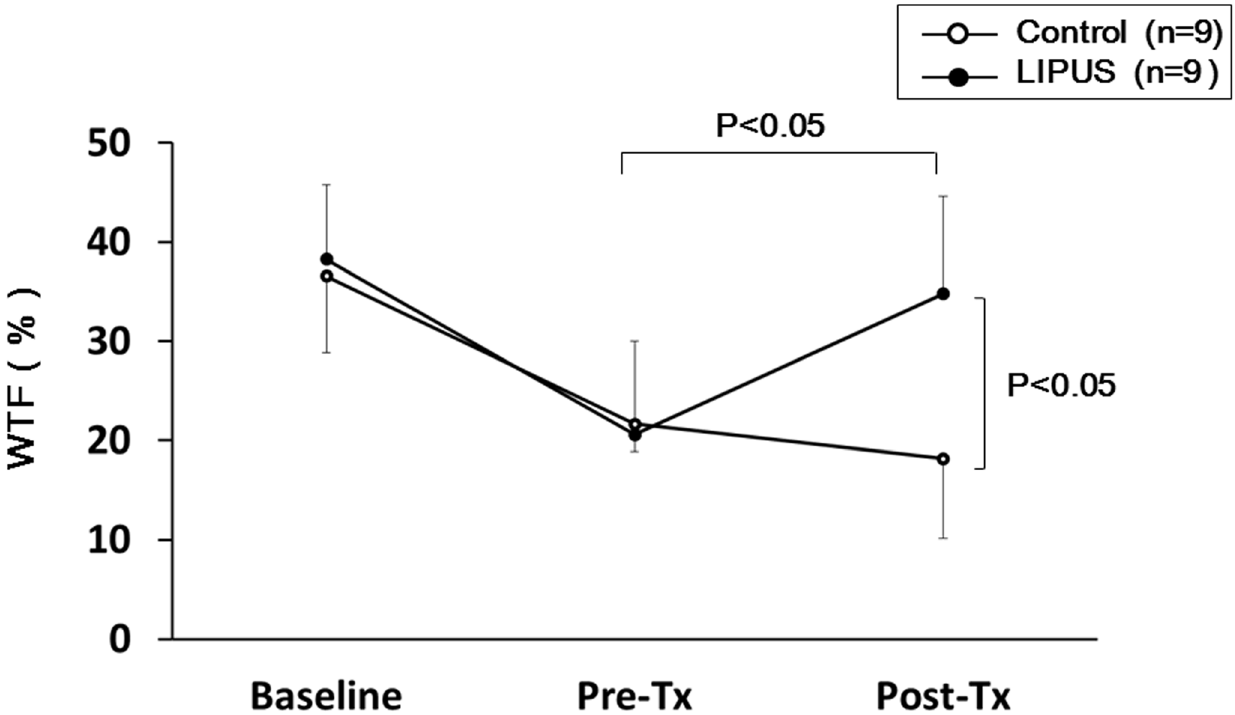
Figure 4. LIPUS therapy improved regional myocardial function in vivo. LIPUS therapy induced a complete recovery of WTF of the ischemic lateral wall. Results are expressed as mean 6 SEM (n=9 each).